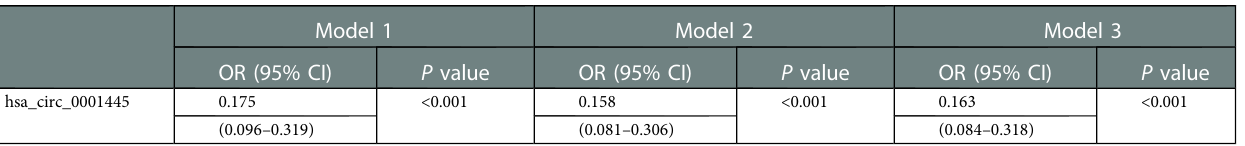
TABLE 3 Logistic regression results.